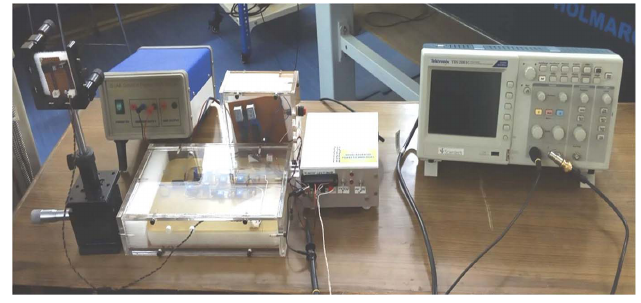
Figure 9 Detection system showing the fringe counter and digital oscilloscope.